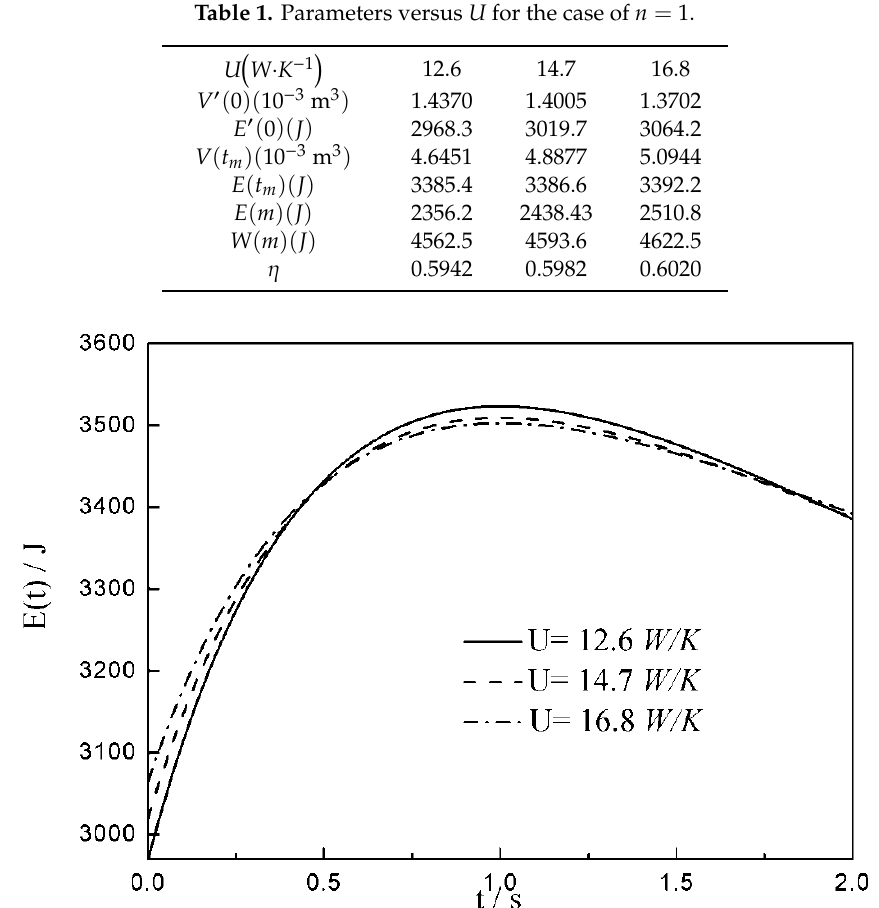
Figure 2. Optimal internal energy versus time as n = 1.